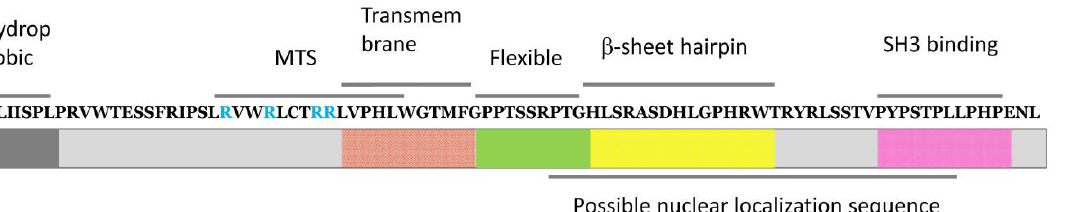
Figure 5. Amino acid sequence and domain architecture of p13 II protein: p13 II has hydrophobic N-